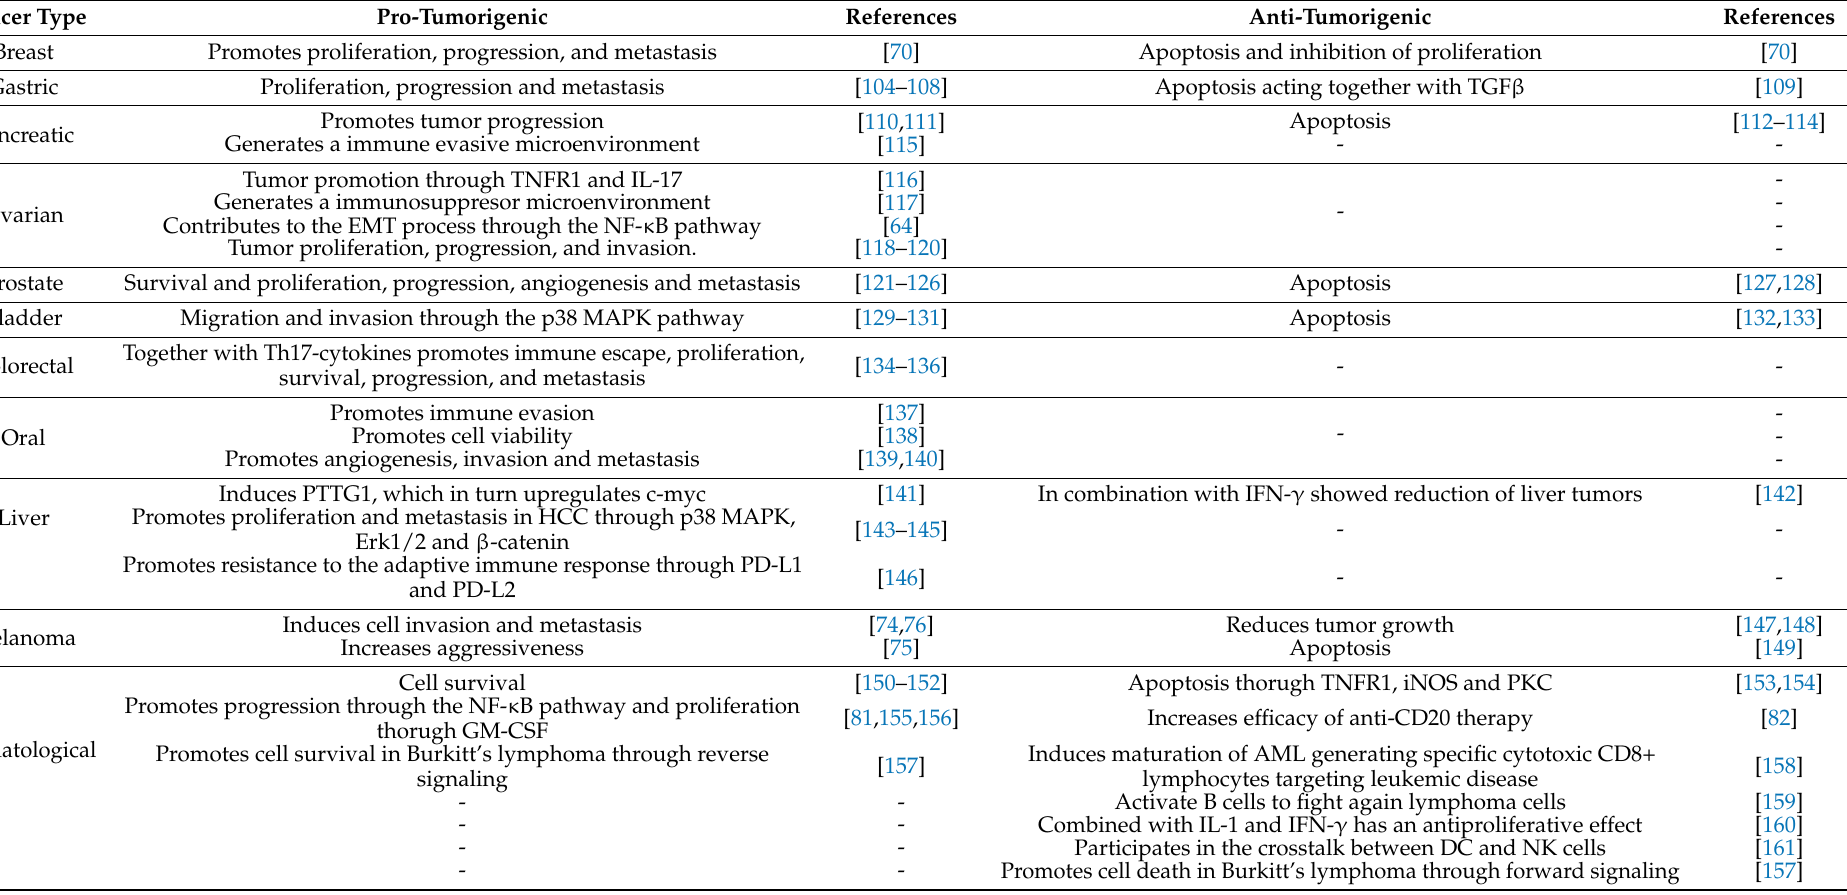
Table 1. Dual role of tumor necrosis factor alpha (TNF α ) in